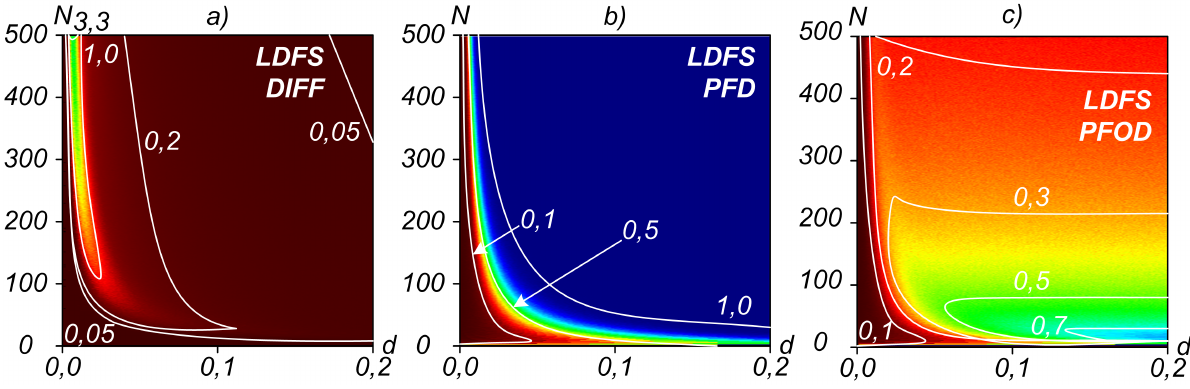
Figure 4: Dependencies of average deviation of the best decision quality from optimum (a), probability of finding decision (b) and probabil- ity of finding optimal decision (c) for depth-first search with limited height of subtrees within combinatorial search tree.